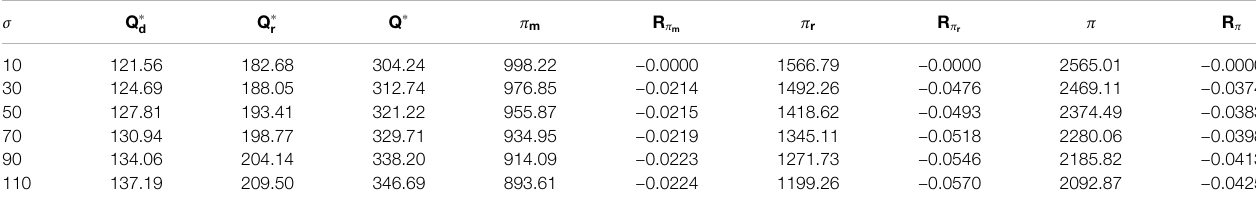
TABLE 2 | Results of the